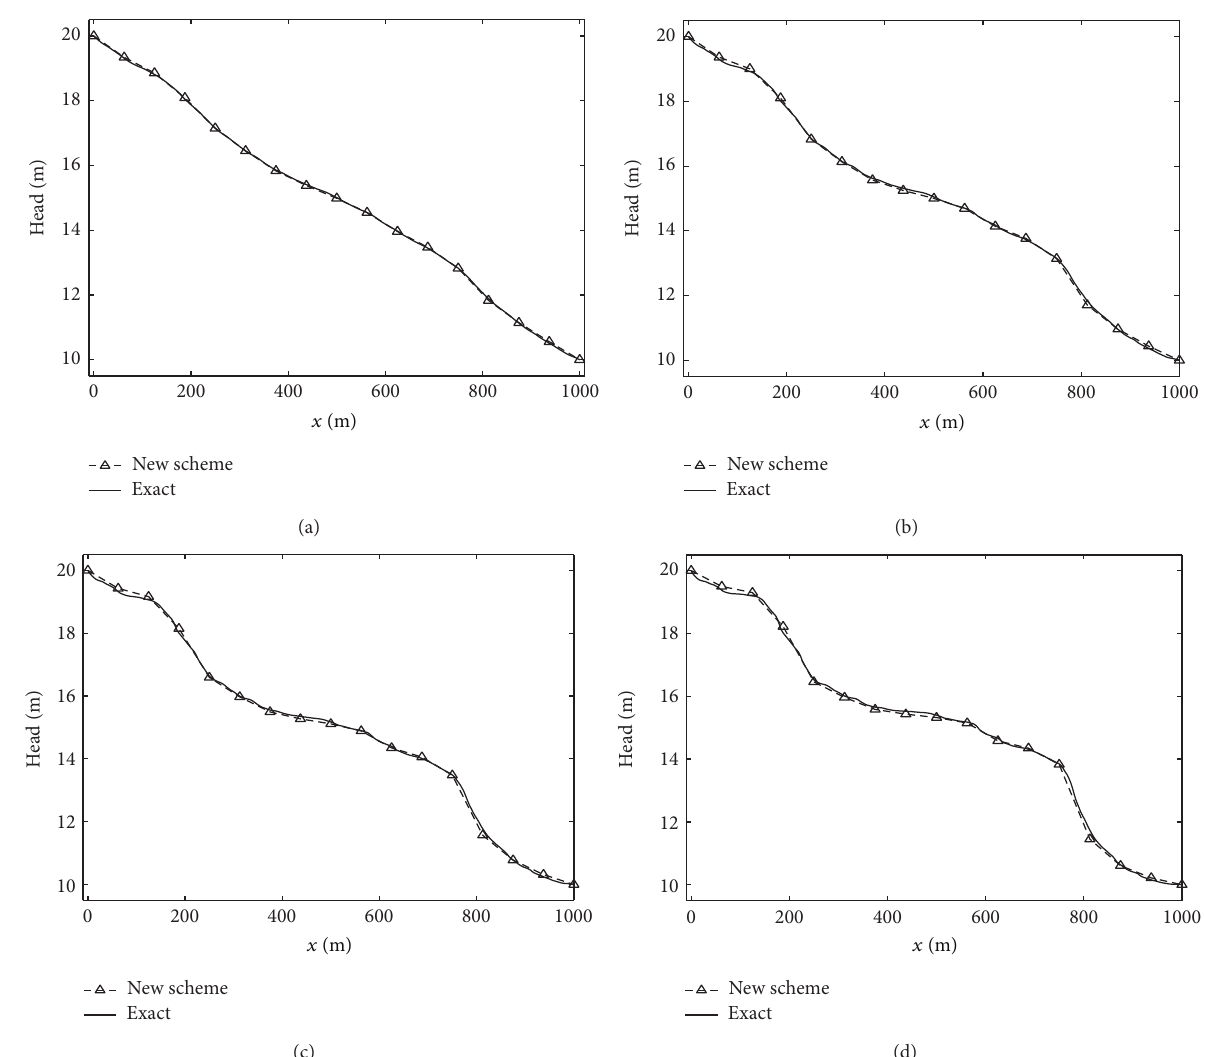
Figure 6: Exact solution and the coarse solution of the new scheme in section 𝑦 = 500 m for the steady flow problem under isotropic correlation microstructure with different standard deviations: (a) 𝜎 ln 𝐾 = 0.5 , (b) 𝜎 ln 𝐾 = 1.0 , (c) 𝜎 ln 𝐾 = 1.5 , and (d) 𝜎 ln 𝐾 = 2.0